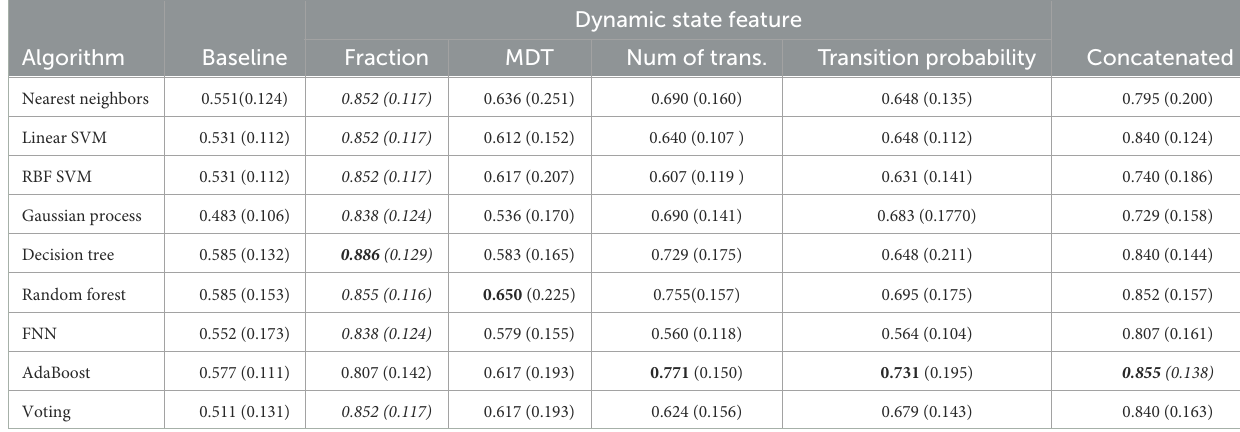
TABLE 4 The prediction accuracy of multiple machine learning algorithms with dynamic state features.